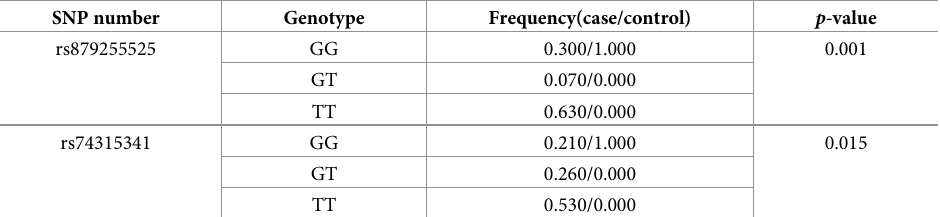
Table 2. Genetic frequency